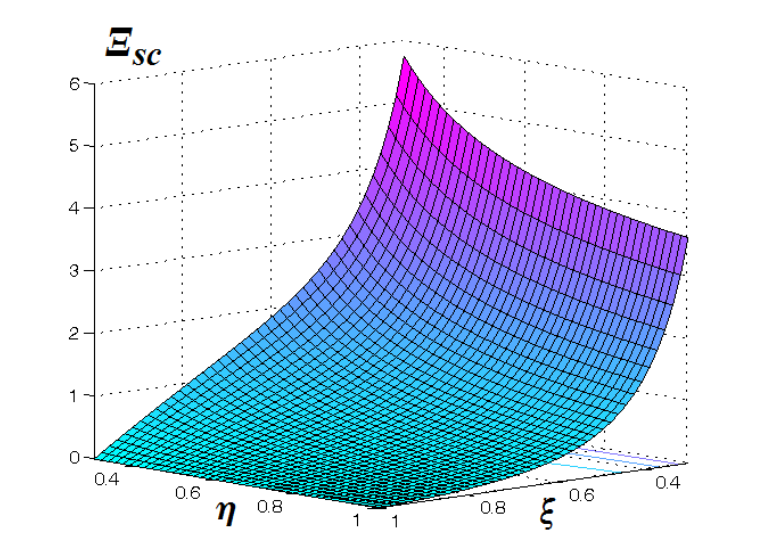
Figure 2. The graph of the function Ξ sc ( ξ , η ) . The argument ξ characterizes the ratio of the radii of the inner and outer boundaries of the liquid layer, and the argument η represents the ratio of the densities of the liquid and the substance of the inner core (assumed